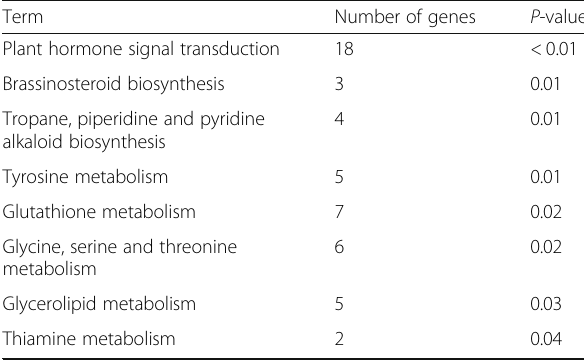
Table 6 KEGG analysis of the response of Rhizoglomus intraradices -inoculated cultivated rice plants to infection by Magnaporthe oryzae in the Cp + R vs. Cp comparison. Cp + R, R. intraradices -inoculated cultivated rice infected with M. oryzae ; Cp, R. intraradices -uninoculated cultivated rice infected with